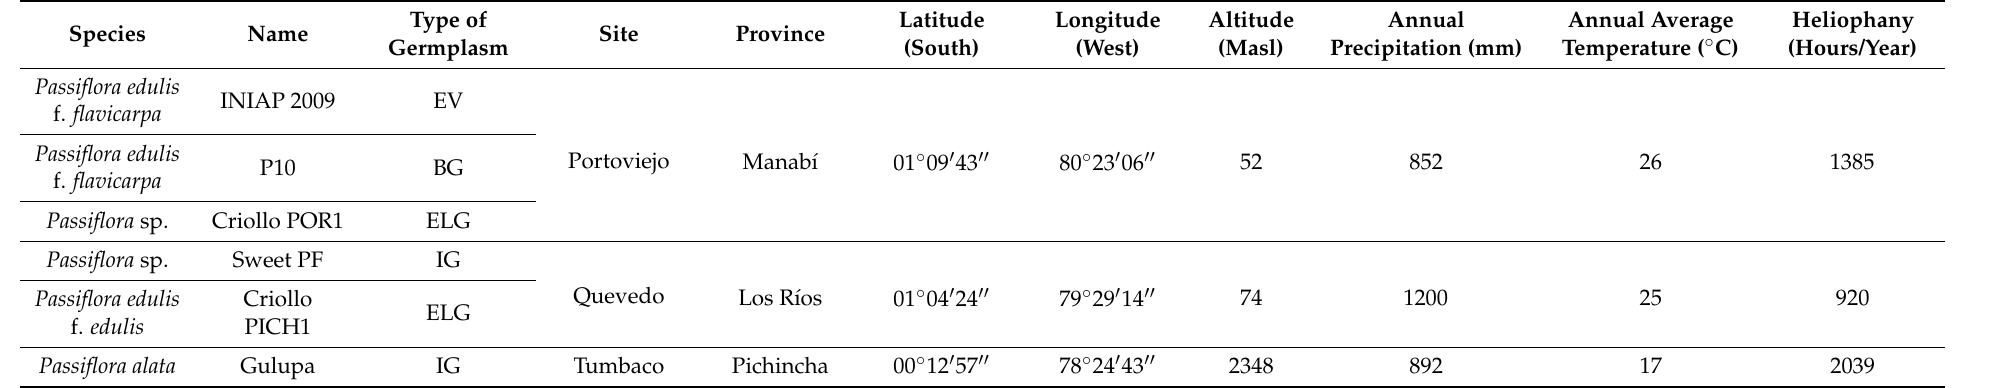
Table 5. Passiflora species analyzed to determine the fruit quality traits and mineral